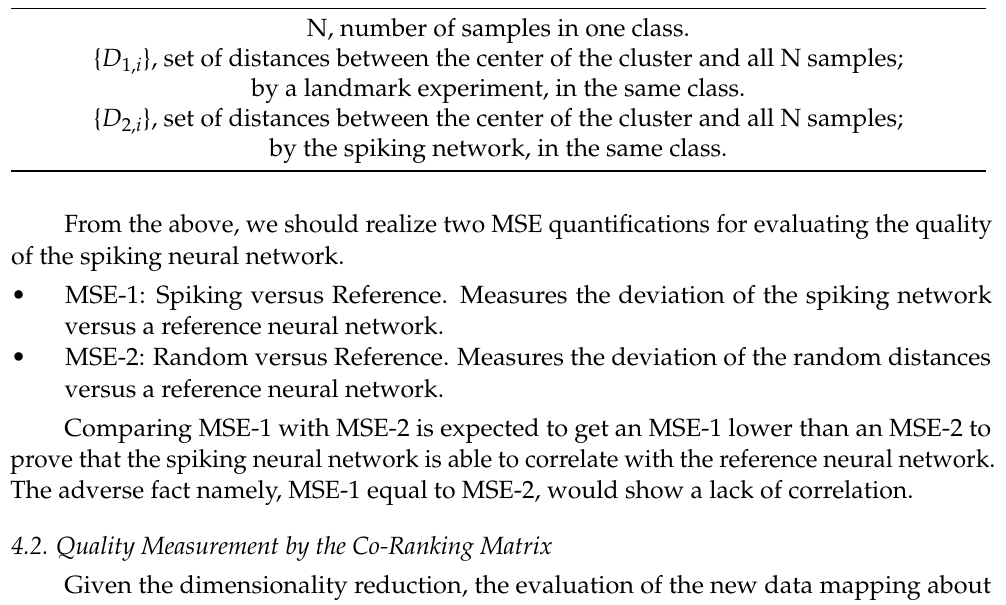
Table 5. Meaning of parameters.